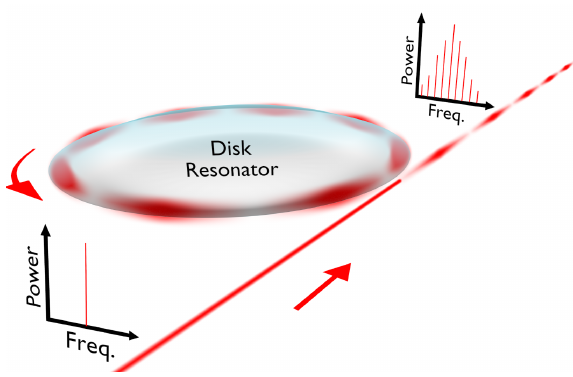
Figure 6: Schematic representation of Kerr optical frequency comb generation using a crystalline disk resonator. In this figure, we con- sider the case where a continuous-wave input pump creates a roll pattern (eighth order) inside the disk resonator, which induces a a periodic intensity modulation along the rim. The output signal spec- trally corresponds to an optical frequency comb with extremely high coherence and robustness, featuring an eight-FSR spacing. Depend- ing on the laser pump power and frequency, many other stationary (solitons) and non-stationary (chaos, breathers) spatiotemporal patterns can be excited inside the nonlinear resonator, as shown in Fig. 5.